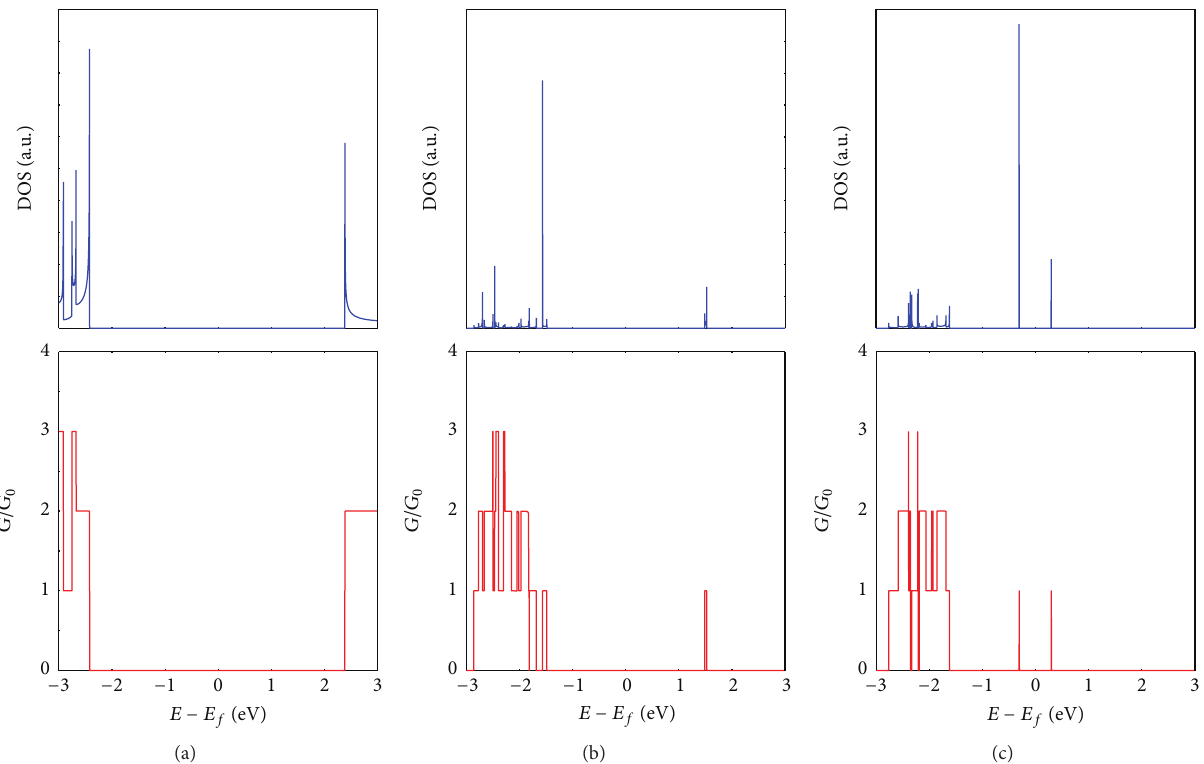
Figure 4: Density of electronic states (blue) and conductance (red, in units of 𝐺 0 = 2 𝑒 2 /ℎ ) of the infinite cubane-based chains for the pristine case (a) and for the COOH- and NO-functionalized cases ((b) and (c),